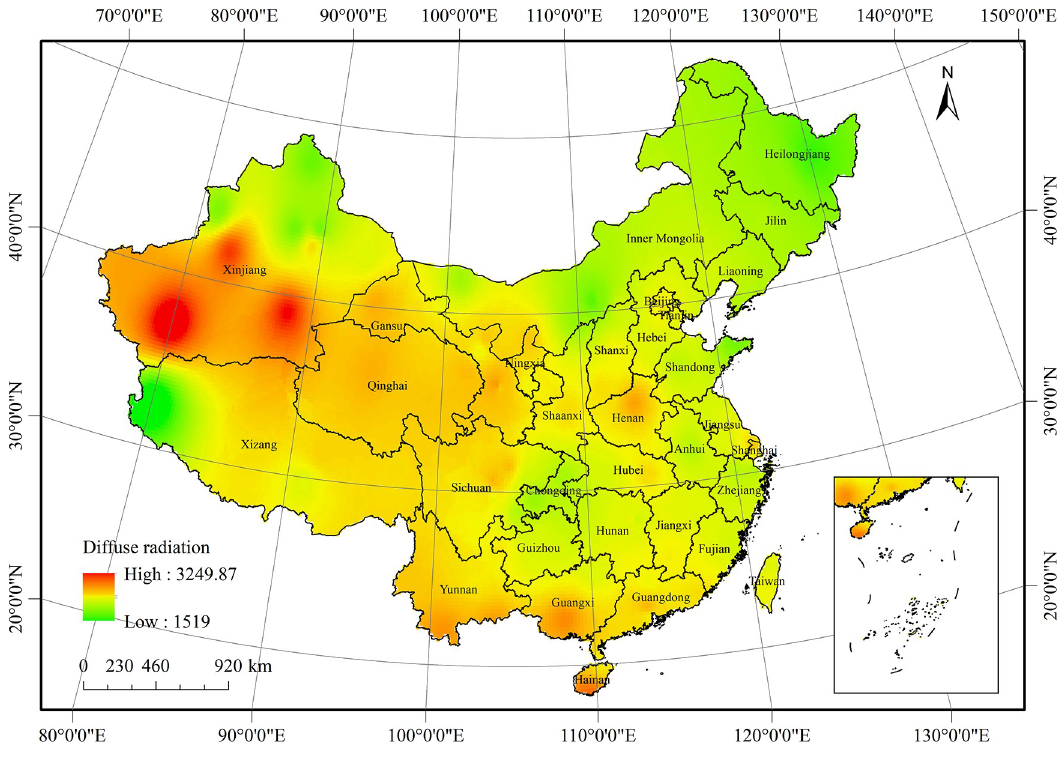
Fig 6. Average distribution of diffuse radiation in China from 1961 to